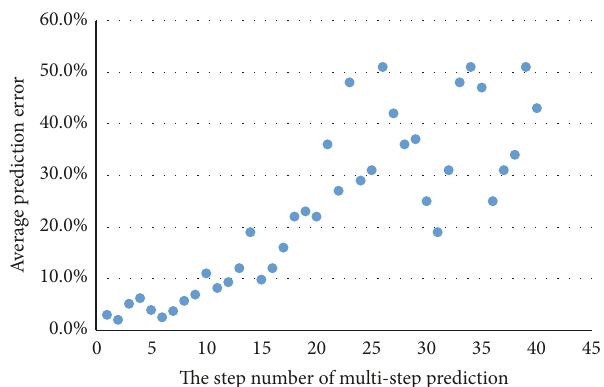
Figure1:Therelationshipbetweentheaveragepredictionerrorsand the number S of